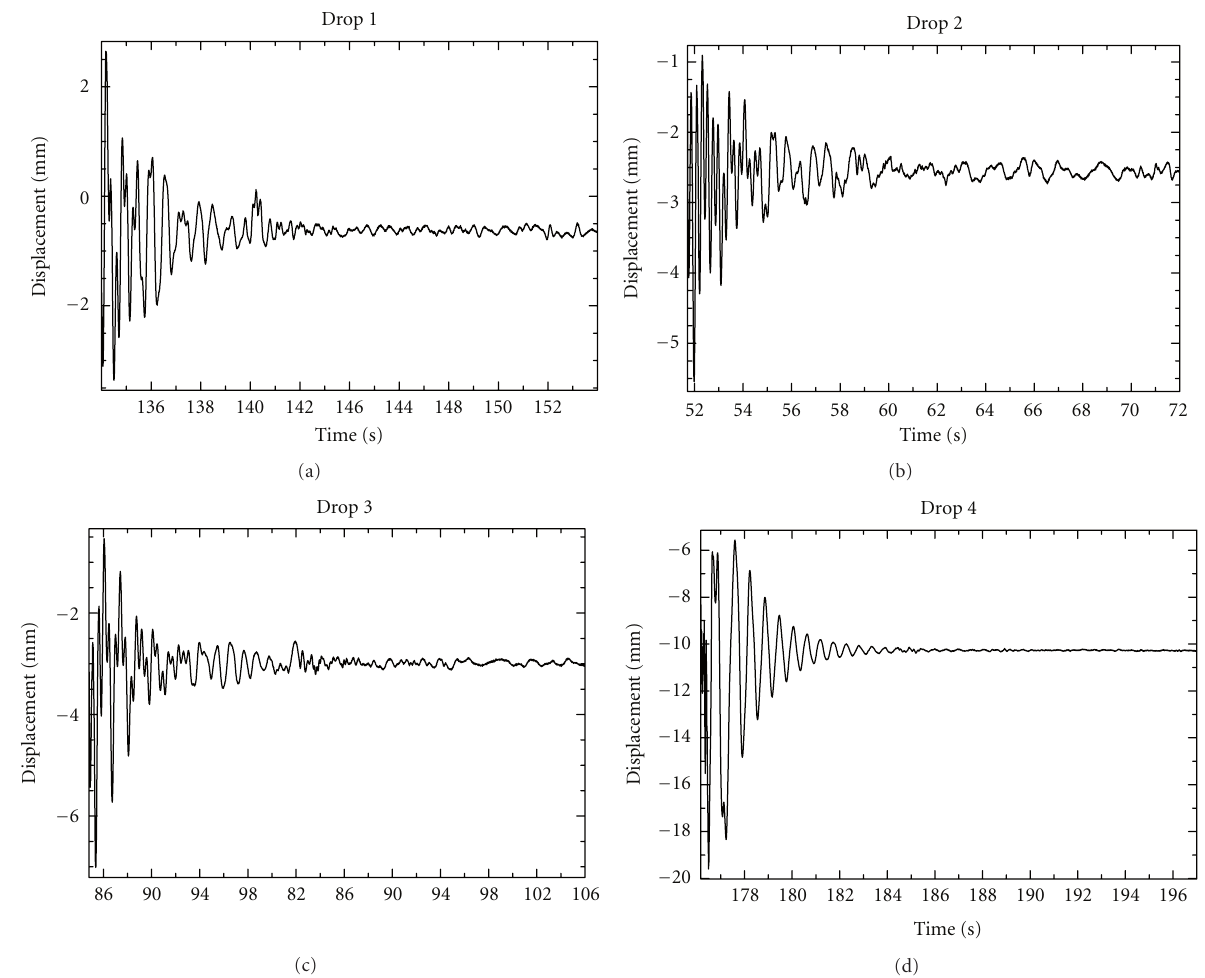
Figure 5: The graphs show the time domain response of the beam after each drop. A time window of about 20 s was considered.